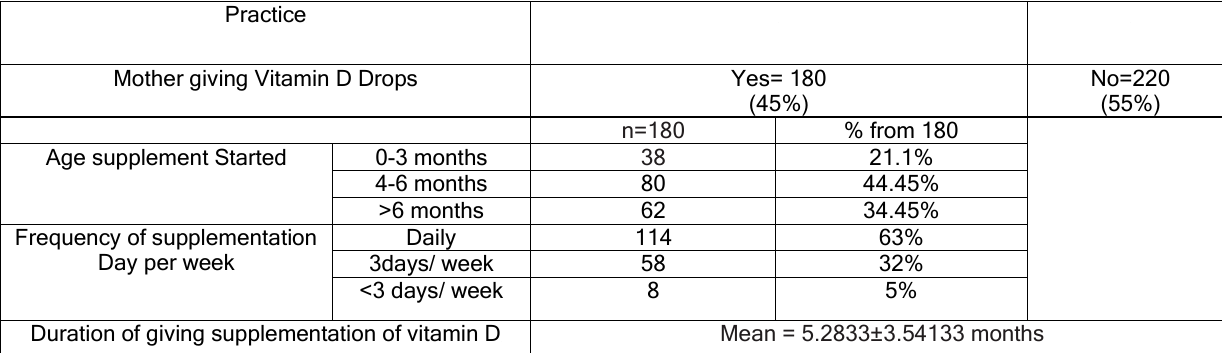
Table 6: Maternal practice toward vitamin D supplementation